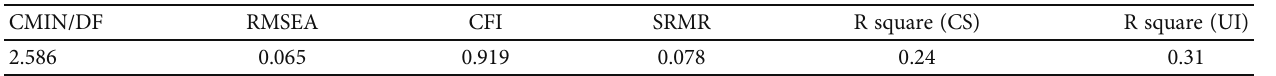
Table 3: Model fi tness